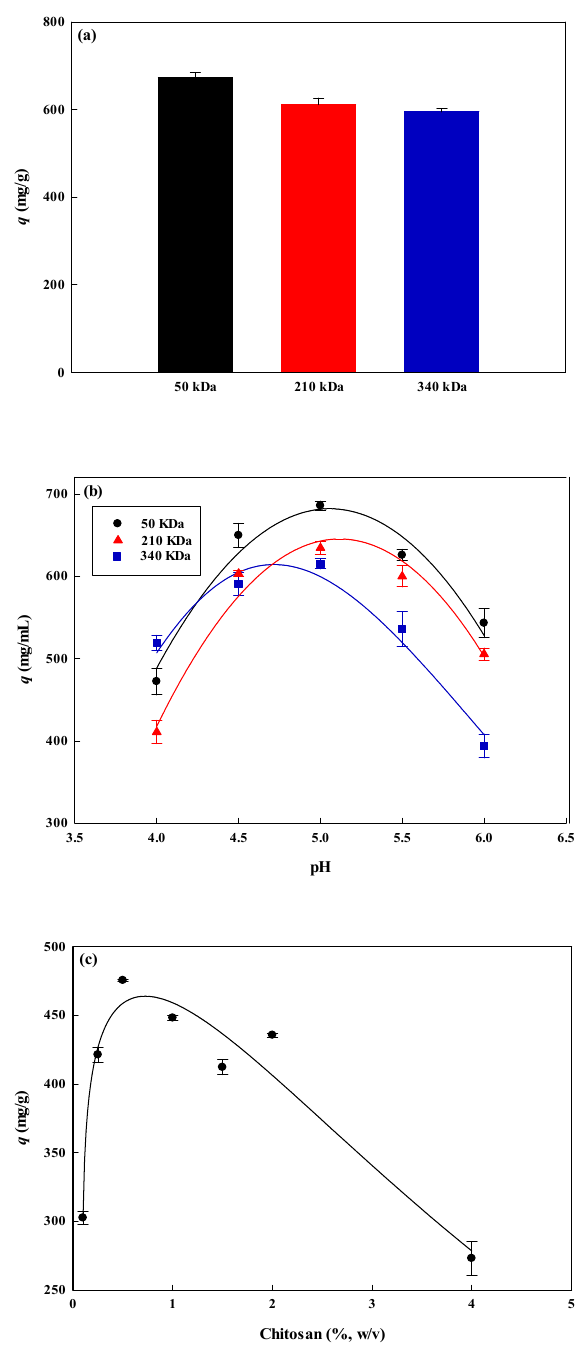
Figure 5. The effect of ( a ) molecular weight of chitosan, ( b ) solution pH, and ( c ) concentration of chitosan (CS) coupled with P-COOH nanofiber membrane on the adsorption capacity for